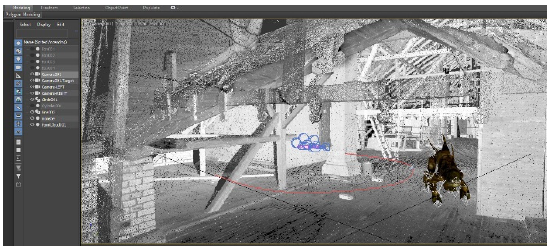
Figure 3. RCS file imported in Autodesk 3D Max (2017)